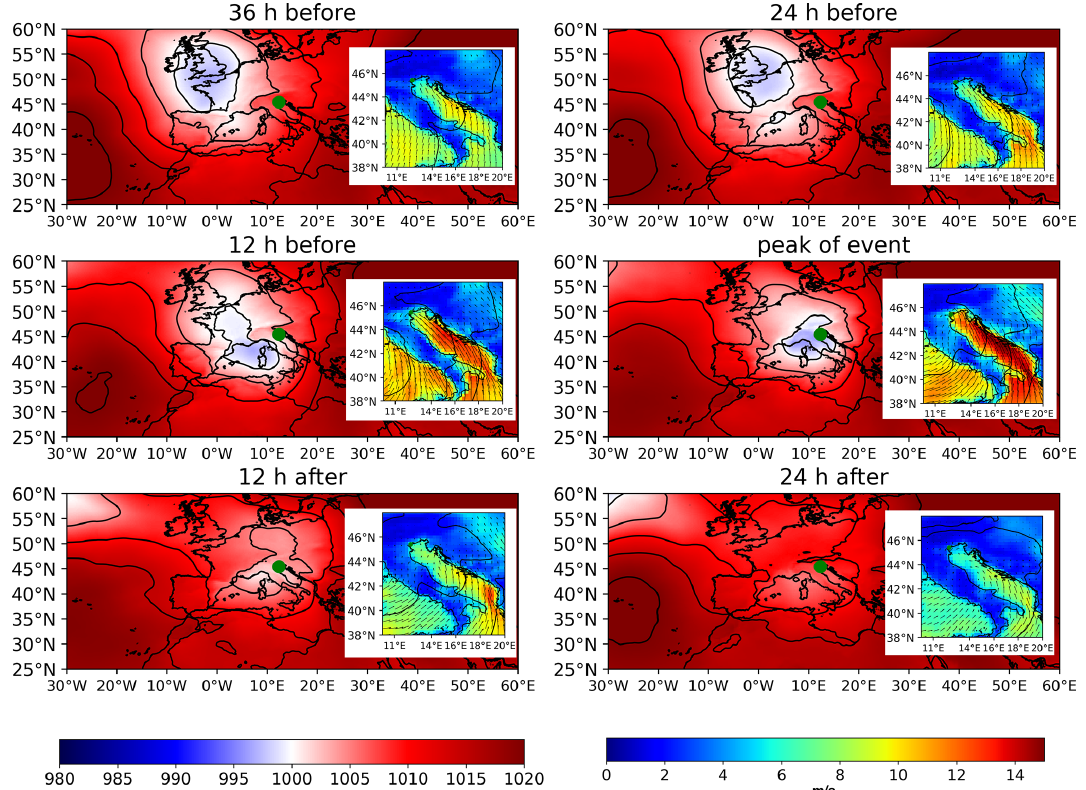
Figure 5. Same as Fig. 2, except it is based on the events in Table 1 with storm surge height lower than 50cm.